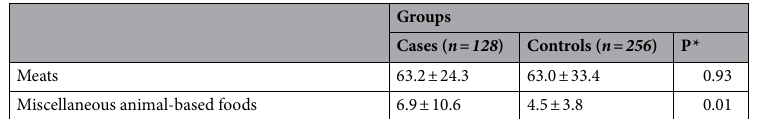
nuts, legumes, vegetable oils, tea/coffee, sweets/desserts and a lower intake of cholesterol, vitamin B12, animal fats, egg, fish/ seafood, meats, and miscellaneous animal-based foods compared with those in the bottom tertile. In addition, participants with the highest score of hPDI had higher intakes of total fats, MUFA, PUFA, magne- sium, whole grains, fruits, vegetables, nuts, legumes, vegetable oils and lower intakes of total energy, cholesterol, vitamin B12, refined grains, sugar-sweetened beverages, fruit juices, potatoes, sweets/desserts animal fats, egg, fish/seafood, meats, and miscellaneous animal-based foods than those with the lowest score. In comparison with subjects in the lowest tertile of uPDI, those in the highest tertile consumed higher amounts of carbohydrates, refined grains, fruit juices, sweets/desserts, animal fats and had lower intakes of total energy, fats, saturated fatty acids (SFA), PUFA, MUFA, cholesterol, vitamin B6, calcium, magnesium, potassium, whole grains, fruits, vegetables, nuts, legumes, vegetable oils, dairy, egg, fish/seafood, and miscellaneous animal-based foods than those with the lowest adherence.